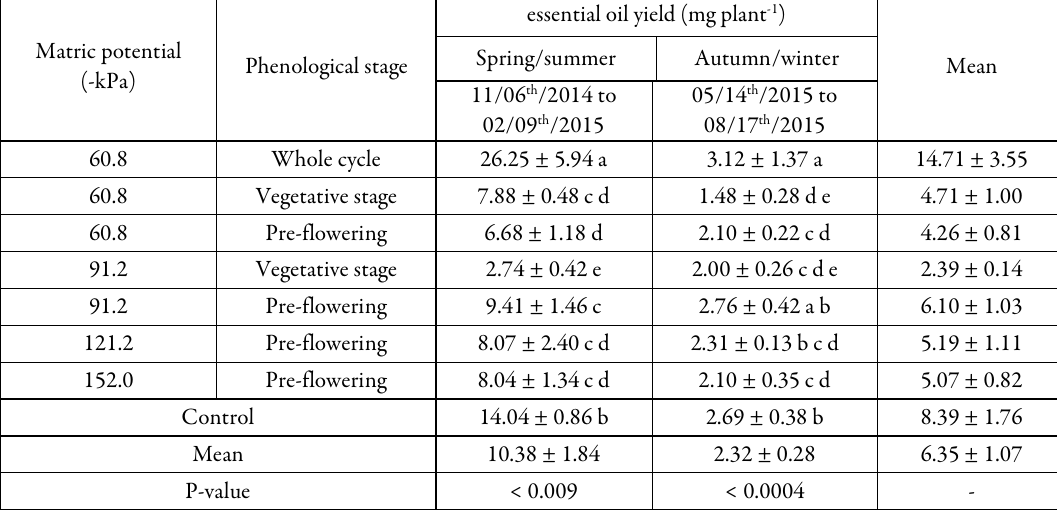
Table 6. Origanum vulgare L. essential oil yield within the experiments Matric